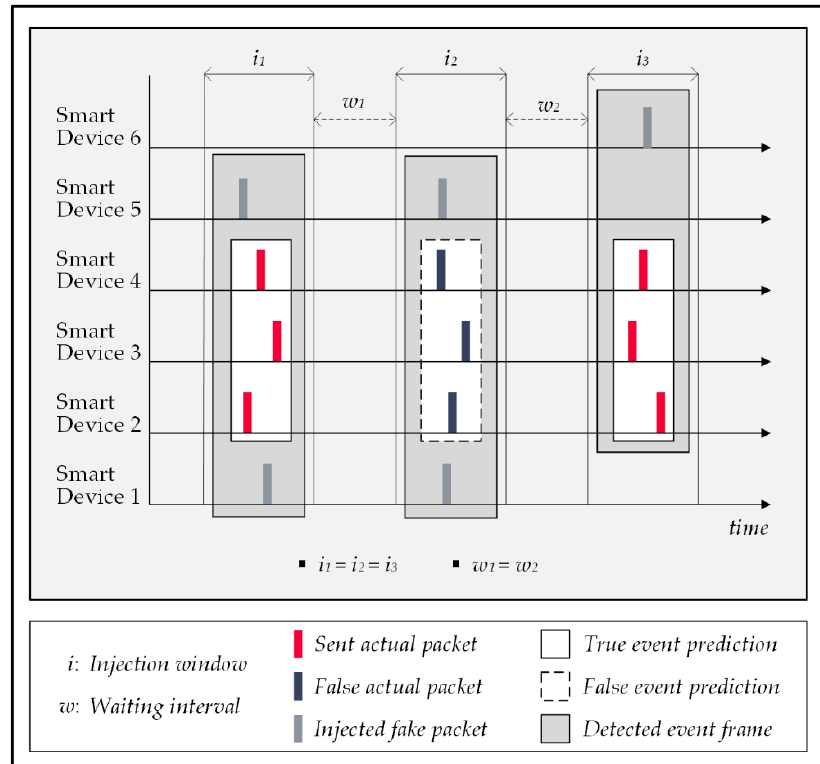
Figure 13. Privacy-preserving method based on events ’ behavioral semantics.